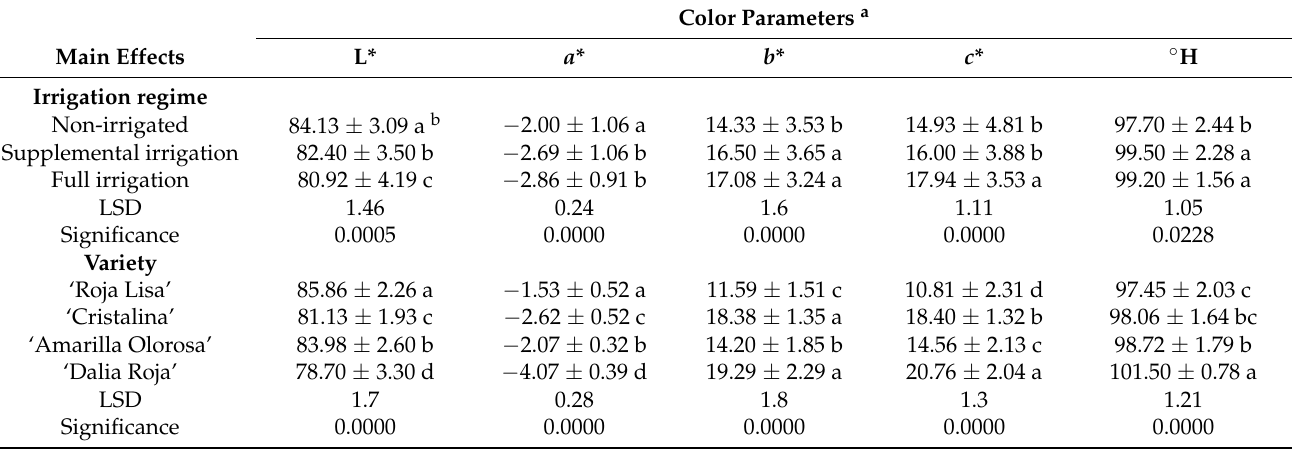
Table 2. Color parameters of freeze-dried mucilage from cladodes of Opuntia varieties subjected to irrigation regimes. Color Parameters a